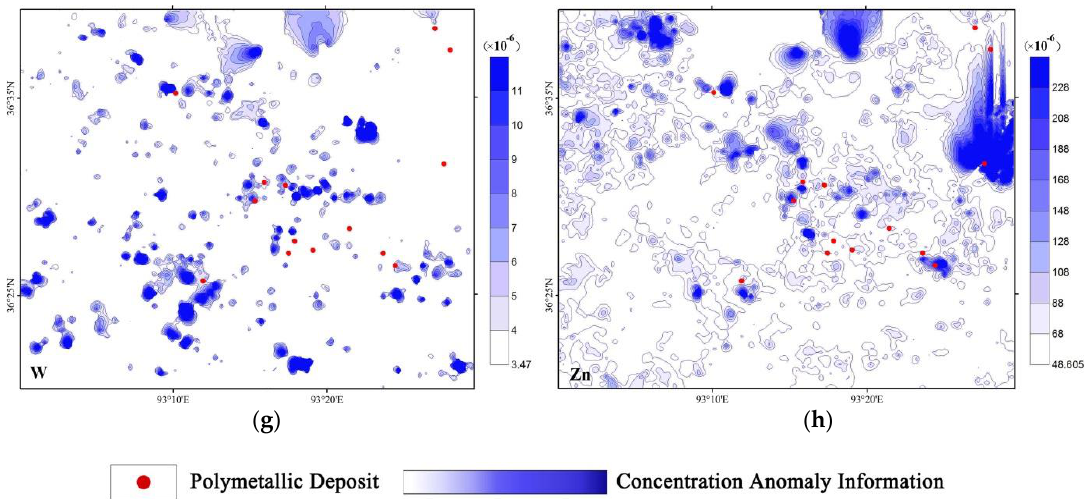
Figure 4. Geochemical anomalies of Ag, Cr, Cu, Mo, Ni, Pb, W, and Zn. ( a ) Geochemical anomaly of Ag; ( b ) Geochemical anomaly of Cr; ( c ) Geochemical anomaly of Cu; ( d ) Geochemical anomaly of Mo; ( e ) Geochemical anomaly of Ni; ( f ) Geochemical anomaly of Pb; ( g ) Geochemical anomaly of W; ( h ) Geochemical anomaly of Zn.